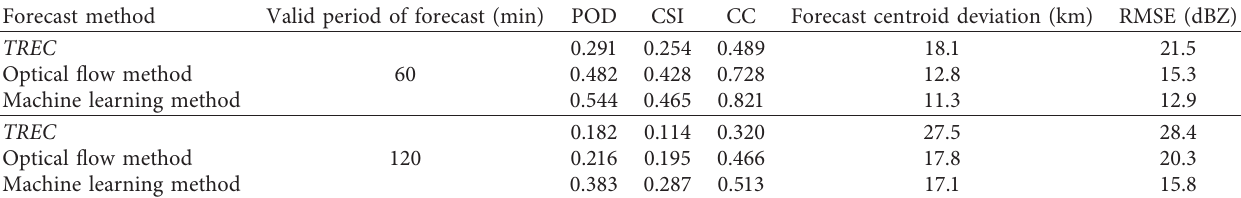
Figure 4: Forecast bias and forecast score for the 2 hours starting at 0400UTC August 1 2017: (a, b) the results of the ConvLSTM method; (c, d) the results of the optical flow Table 3: Results of the comprehensive assessment.